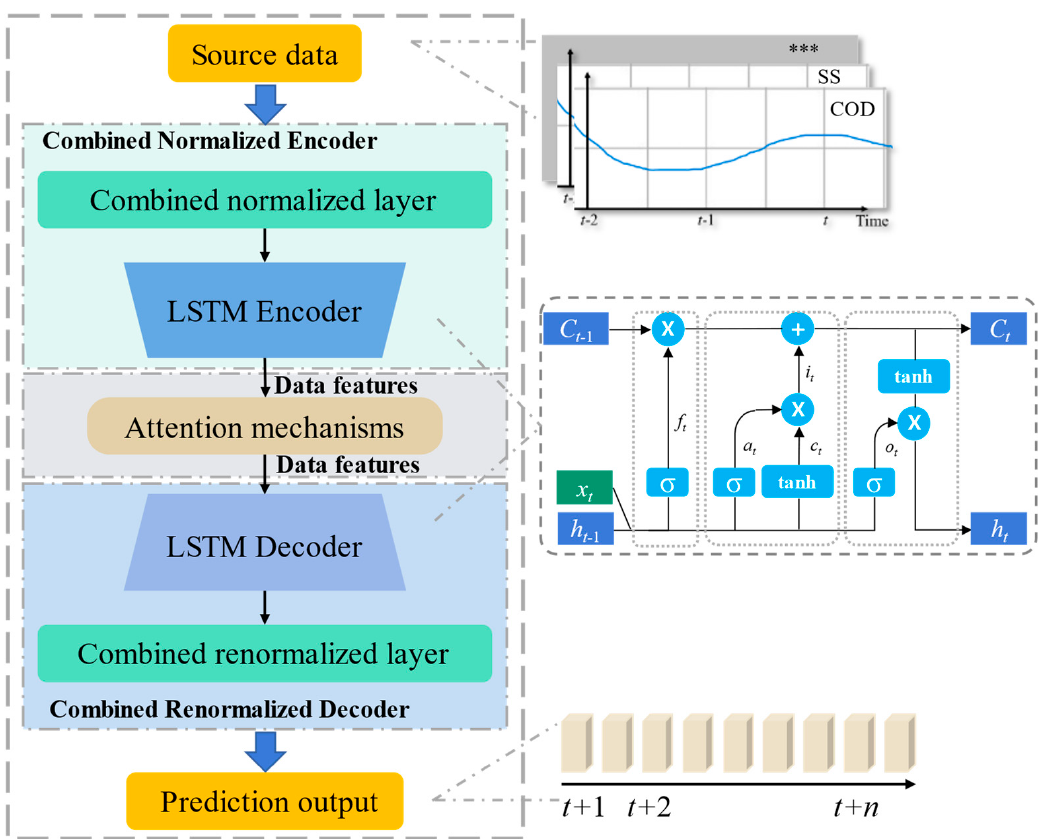
Figure 1. Model structure of the combined normalization codec (CNC).